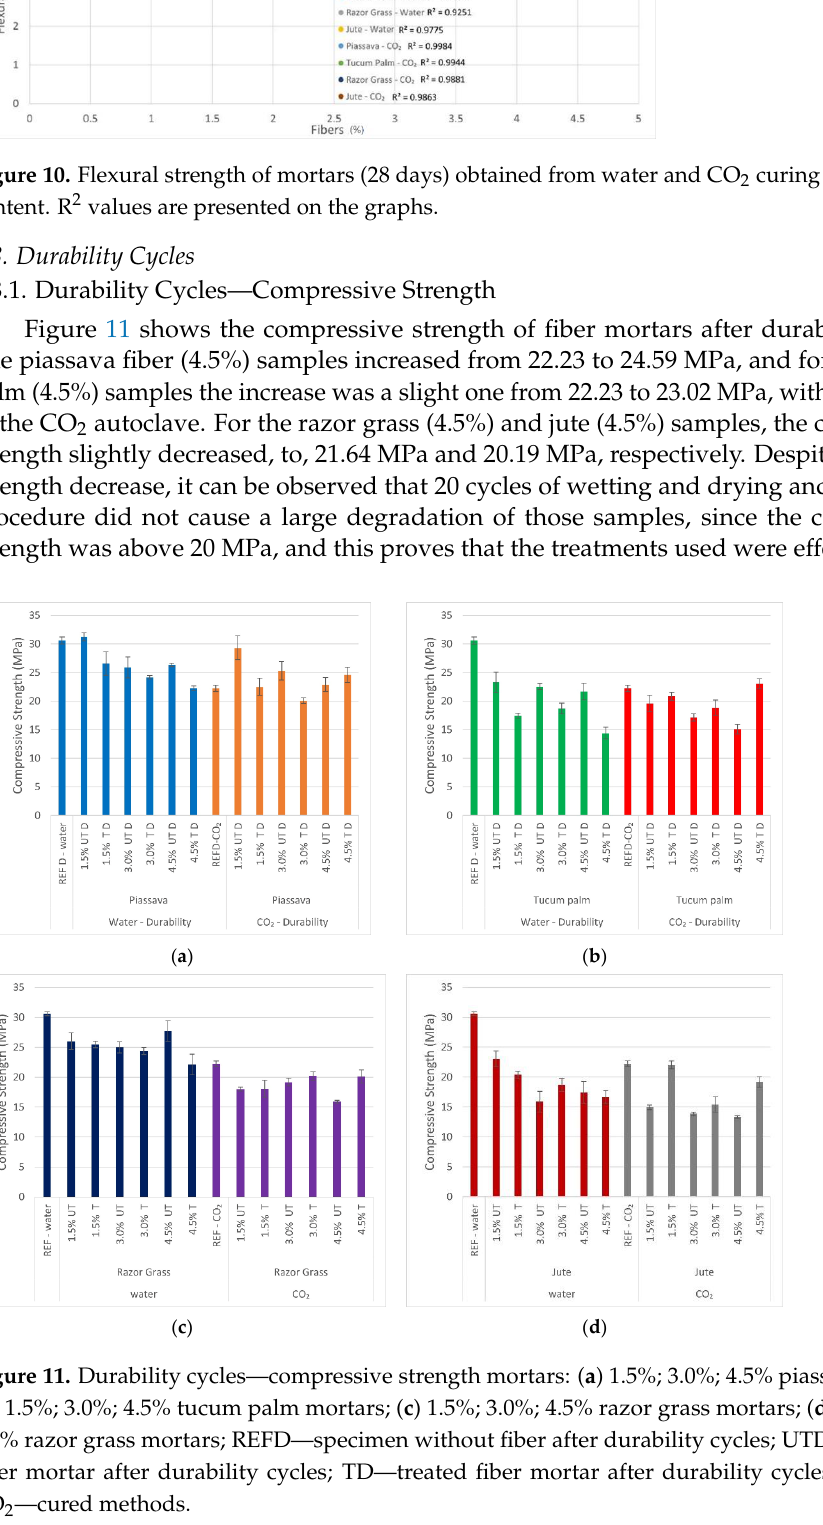
Figure 9. Flexural strength of mortars at 28 days obtained with samples cured with water and CO 2 : ( a ) 1.5%; 3.0%; 4.5% piassava mortars; ( b ) 1.5%; 3.0%; 4.5% tucum palm mortars; ( c ) 1.5%; 3.0%; 4.5% razor grass mortars; ( d ) 1.5%; 3.0%; 4.5% razor grass mortars; REF — specimen without fiber ; UT — untreated fiber mortar; T — treated fiber mortar; water and CO 2 — cured methods.